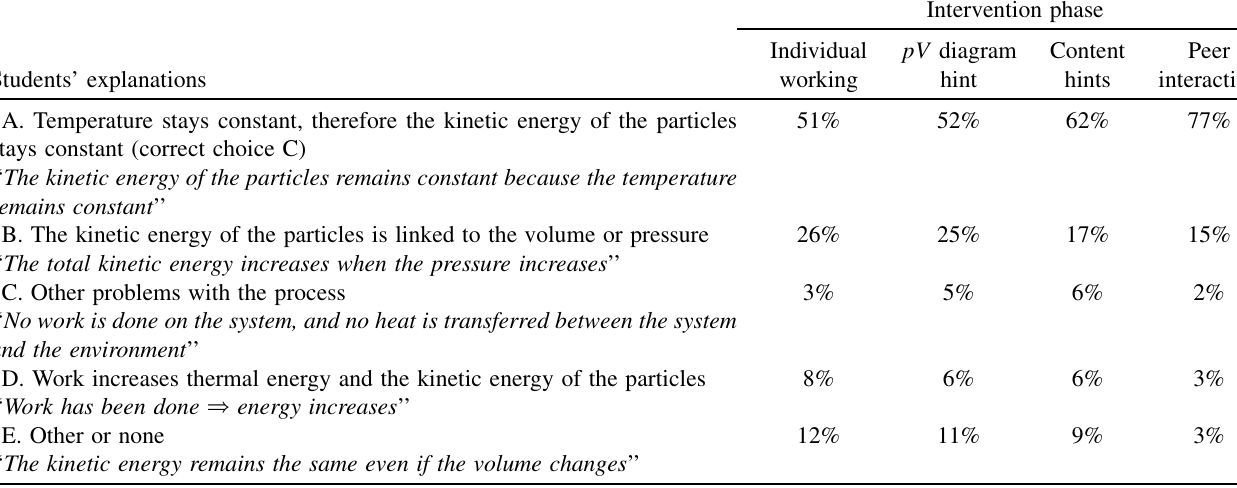
TABLE IX. Students’ categorized explanations regarding change in the kinetic energy of particles in an isothermal compression process. N ¼ 65 . A typical example from each category is presented after the category symbol and title in